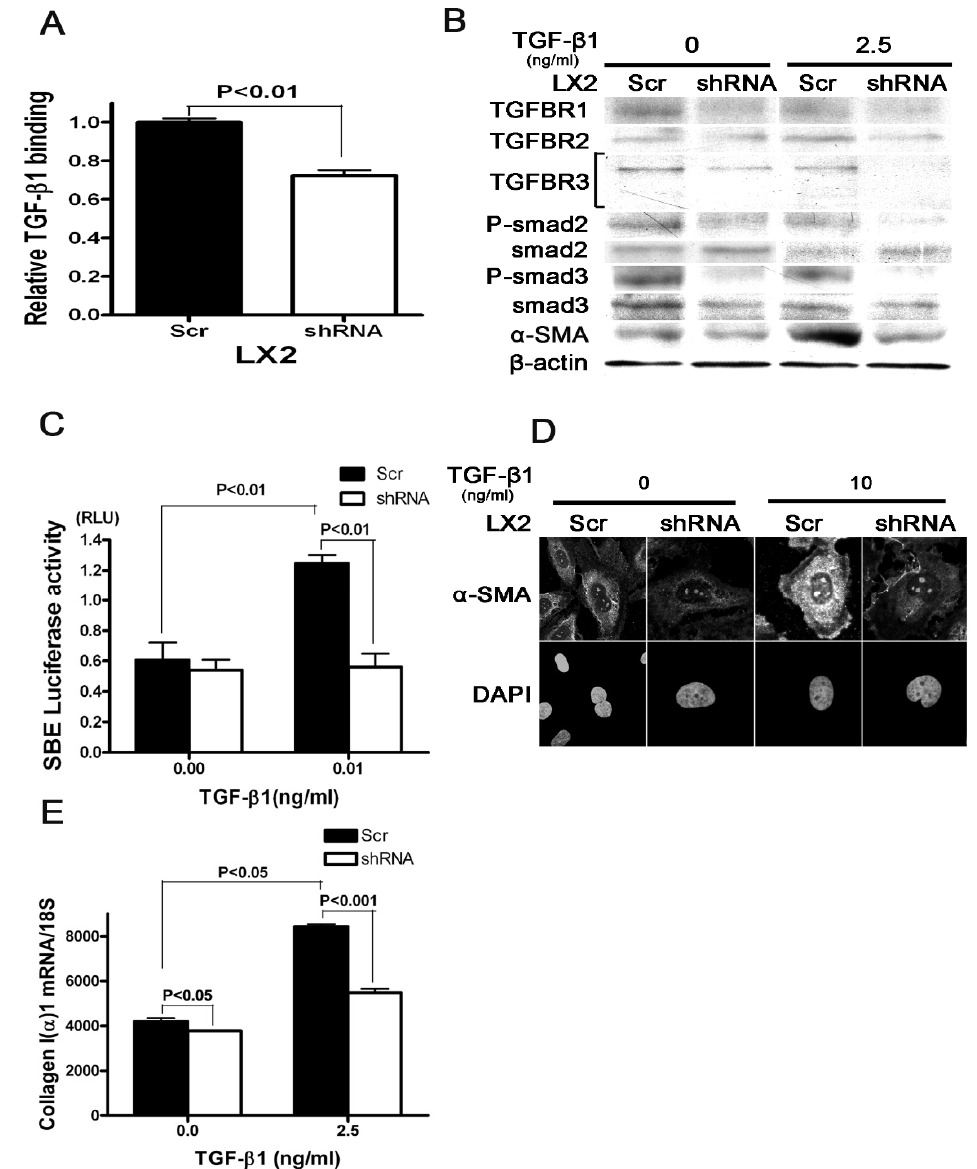
Figure 5. SULF2 knockdown reduces the activation of the TGF- β signaling pathway after TGF- β 1 stimulation in human hepatic stellate cells. ( A ) Relative TGF- β 1 binding in human hepatic stellate cells by flow cytometry. ( B ) Expression of TGF- β receptors, phosphorylation of smad2/3 and α -SMA at 24 h after TGF- β 1 stimulation. ( C ) Luciferase assay at 12 h after TGF- β 1 stimulation using the normalization vector and SBE12-lux aptamer vectors. ( D ) Expression of α -SMA in human HSCs at 24 h after TGF- β 1 stimulation in immunofluorescence (20×). ( E ) Levels of collagen I( α )1 mRNA in human HSCs at 24 h after TGF- β 1 stimulation by RT-PCR. ( B , D , E ) Cells were incubated in 1% FBS for 24 h and then TGF- β 1 (2.5 ng/mL) was added. After 24 h, the assay was performed. 18S is shown as loading controls. Data in each experiment are presented as the mean ± standard deviation of triplicates from one representative experiment. Uncropped Western Blot figures are shown in Figure S1.